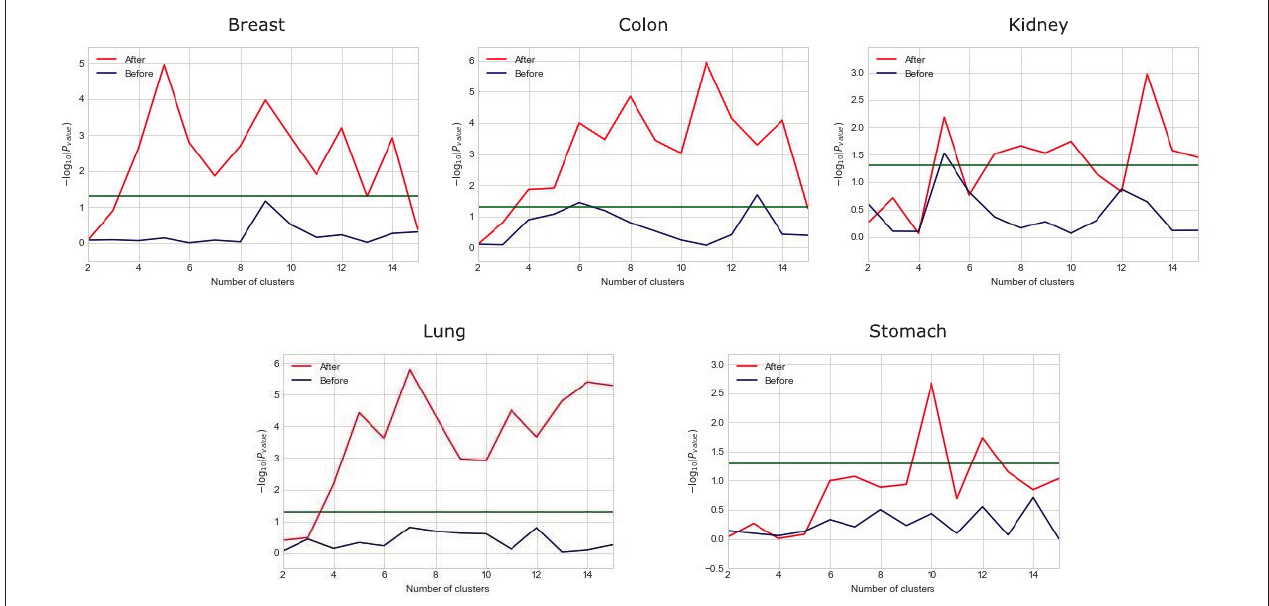
FIGURE 4 | Comparison between the performance of expression data before and after selection by LASSO.